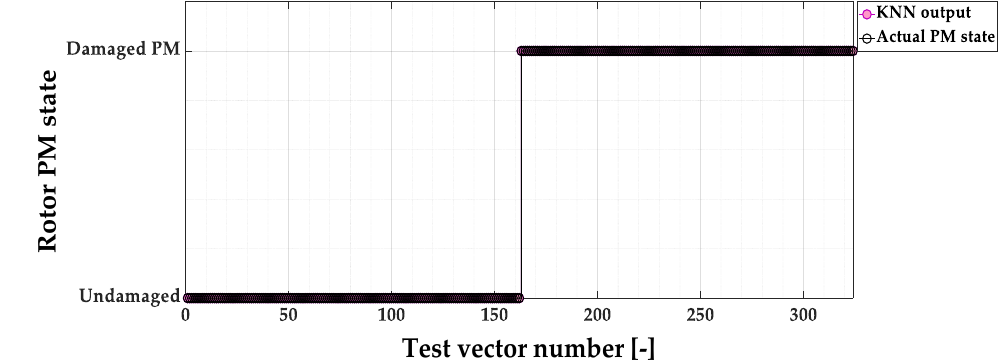
Figure 13. KNN-based PM magnet damage detector responses to the test vectors.